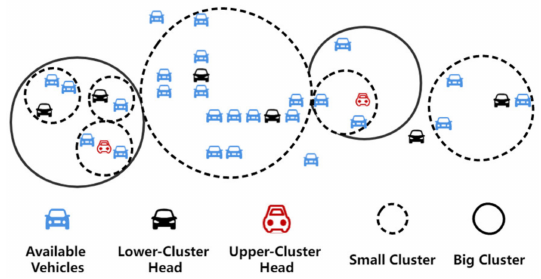
Figure 3. The formation of the